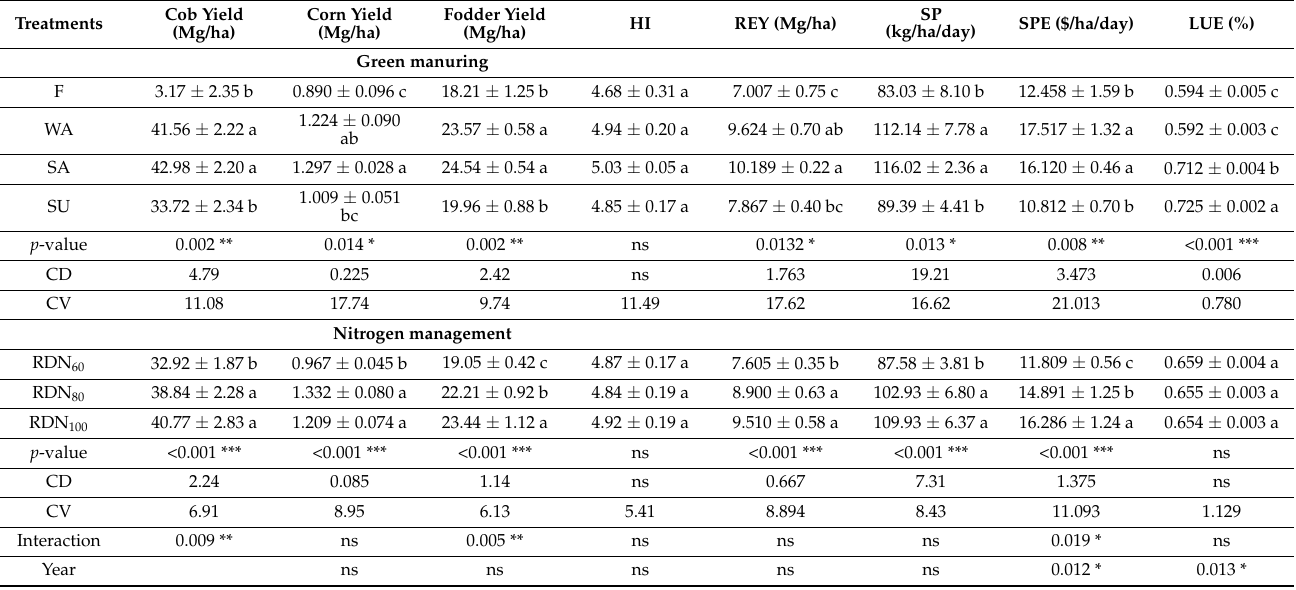
Table 4. Effect of summer green manuring and nitrogen management on yield attributes and system efficiencies of succeeding baby corn.